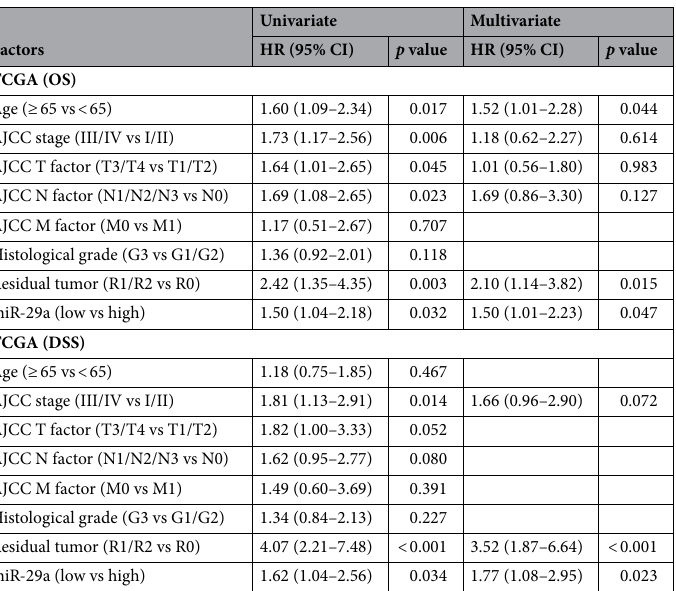
Table 1. Univariate and Multivariate analysis of miR-29a and other factors in